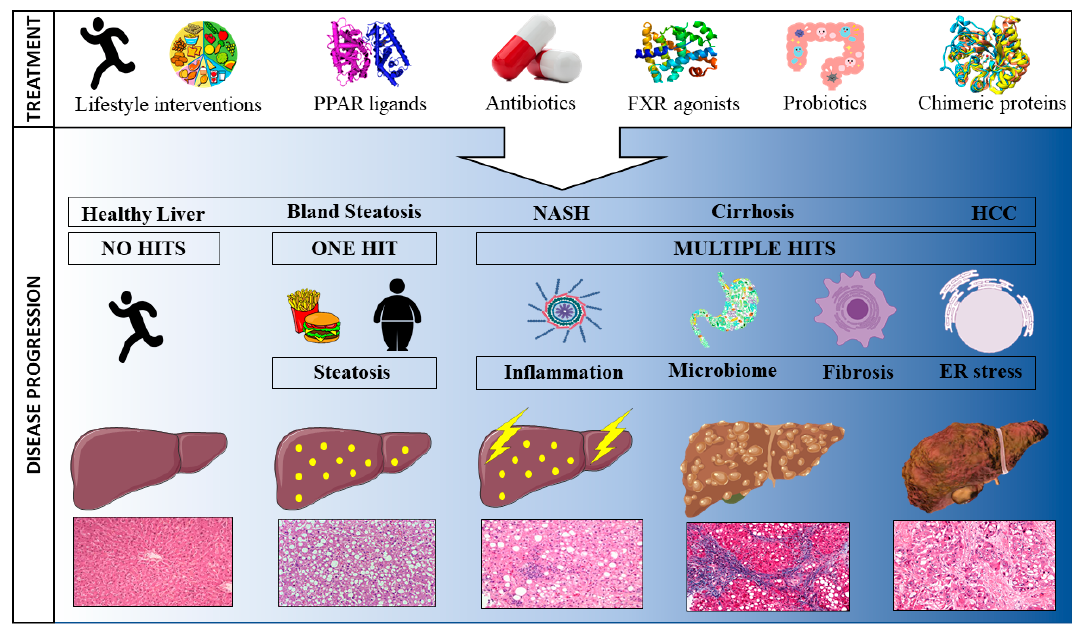
Figure 1. Schematic representation of the progression towards hepatocellular carcinoma and potential treatments to attenuate disease progression.